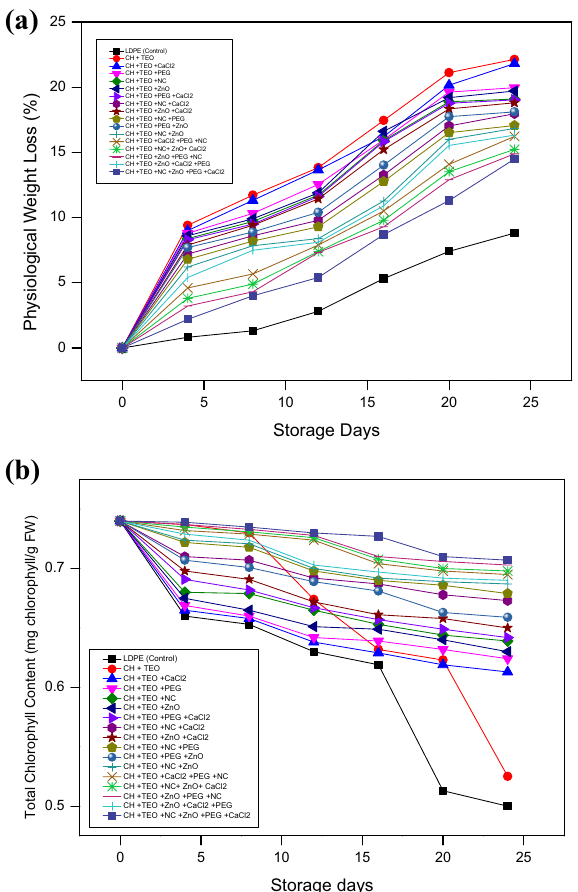
Figure 2. ( a ) Effect of different chitosan-based films and storage days on physiological weight loss (%) of collard greens. ( b) Effect of different chitosan-based films and storage days on total chlorophyll (mg chlorophyll/g FW) content of collard